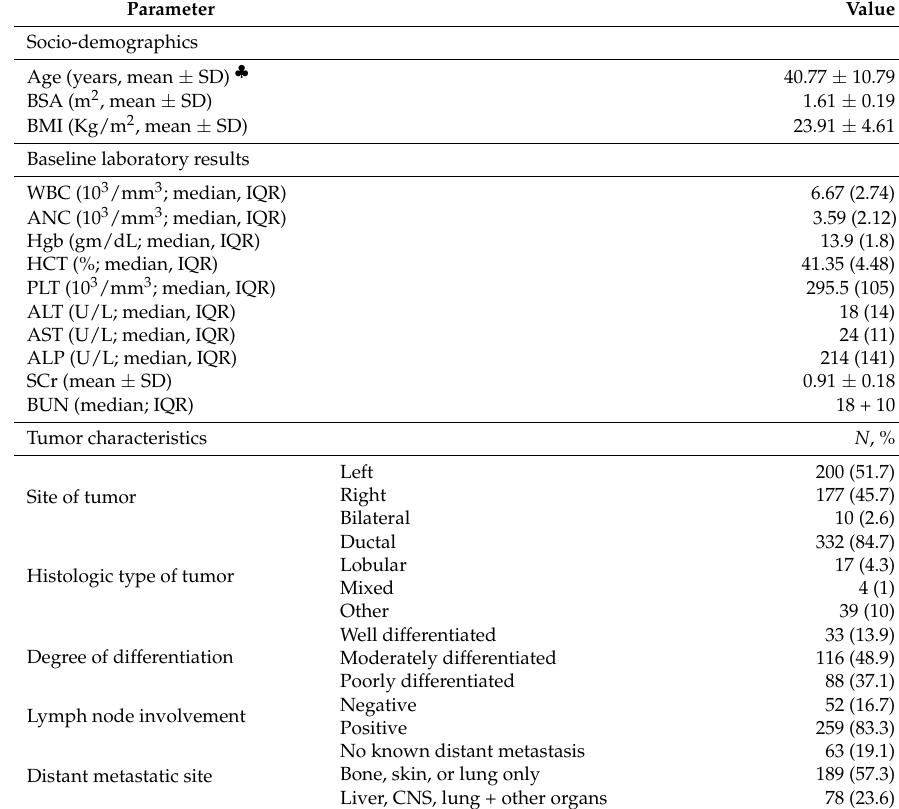
Figure 1 . Study flow chart depicting study groups and participant recruitment. Figure 1. Study flow chart depicting study groups and participant recruitment. Table 1. Socio-demographic, clinical, and laboratory parameters and tumor characteristics of patient participants at